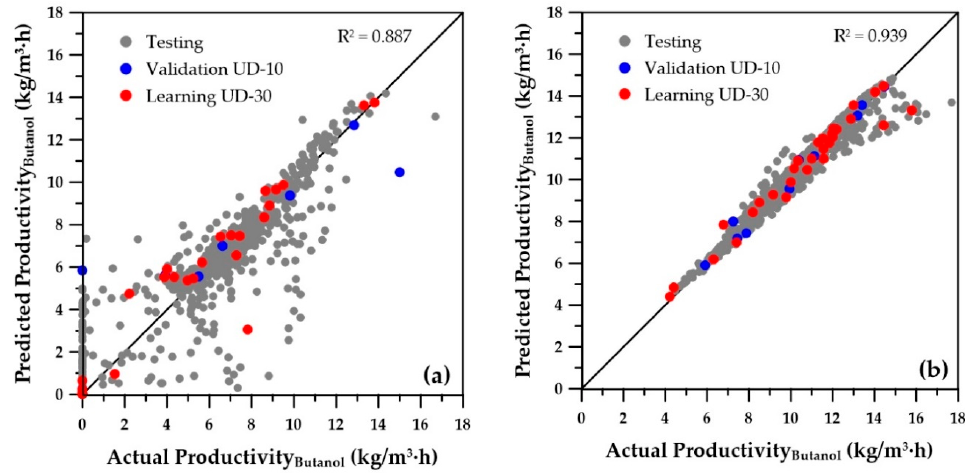
Figure 6. Predicted versus actual butanol productivity for ( a ) initial ranges and ( b ) reduced ranges of the five decision variables.